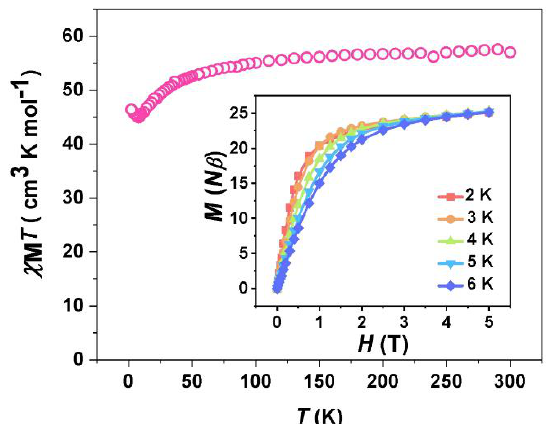
Figure 4. Temperature dependence of magnetic susceptibility for complex 1 ( H dc = 1000 Oe). Inset: Field dependence of magnetization for complex 1 at 2, 3, 4, 5 and 6